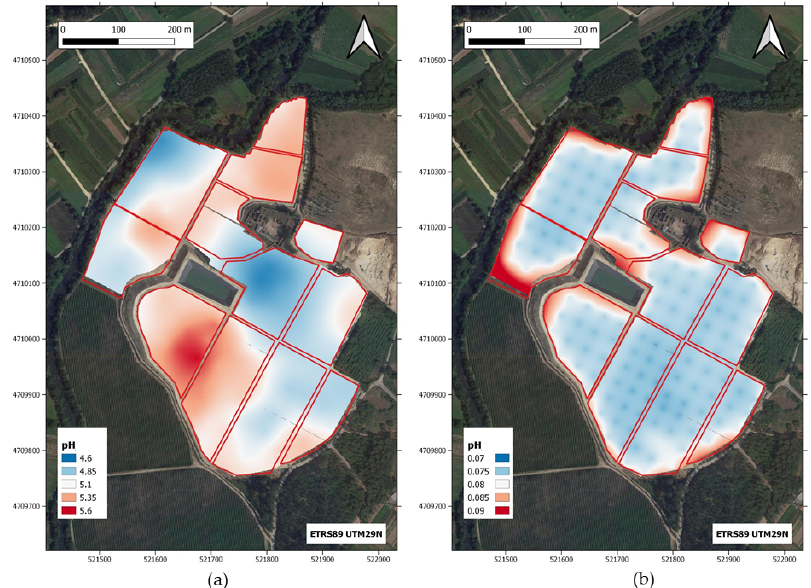
Figure 5. Estimation ( a ) and error ( b ) maps of pH in water over the experimental vineyard generated by ordinary kriging. This variable is dimensionless.